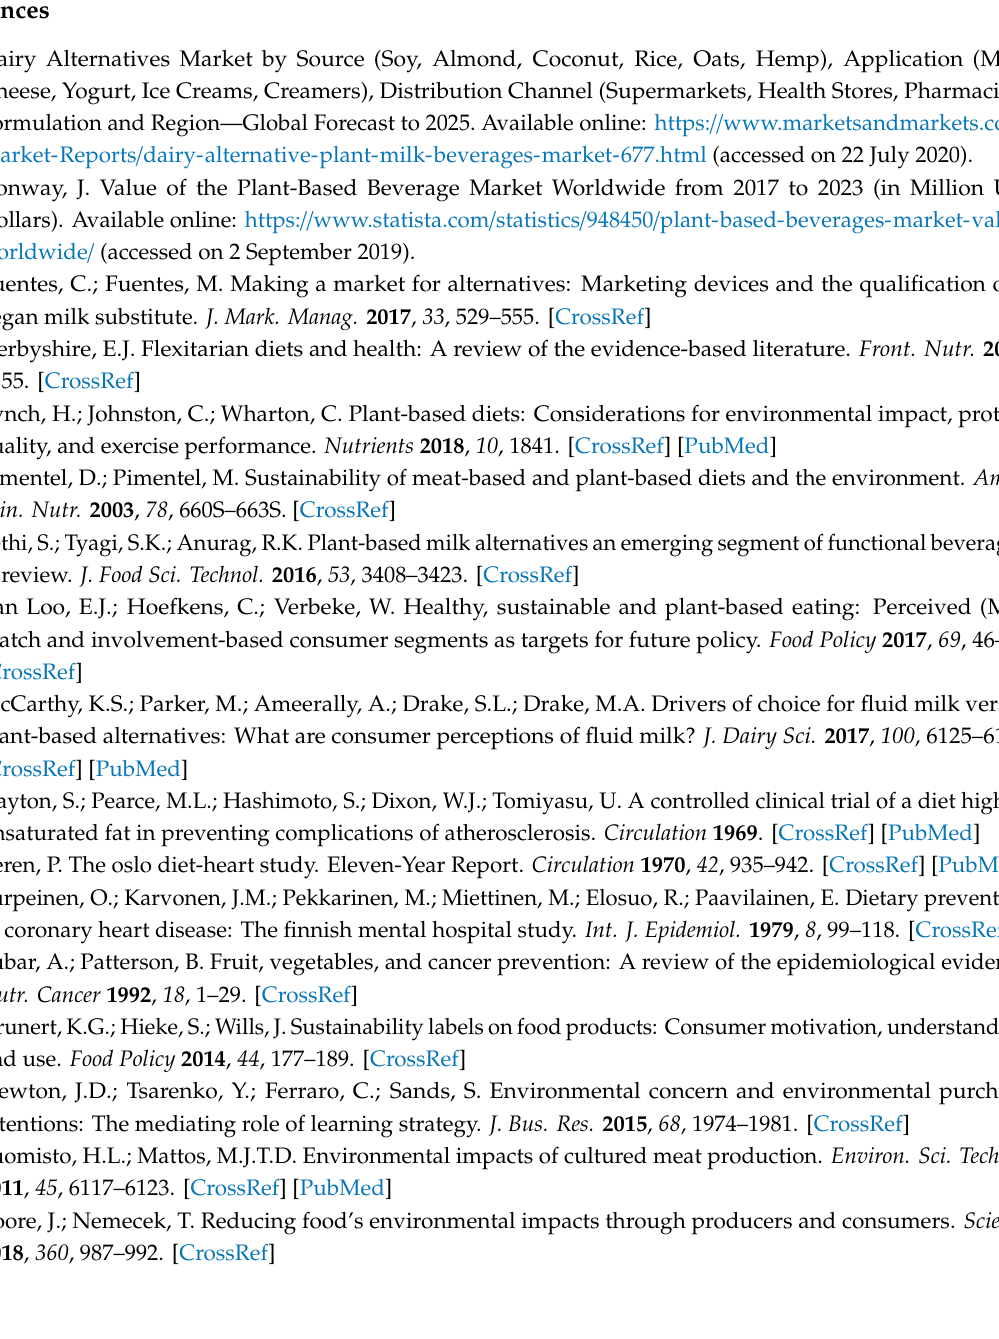
Table S1: Composition of evaluated PBMA and cow’s milk from packaging label and after CHNS analysis of protein content from freeze-dried